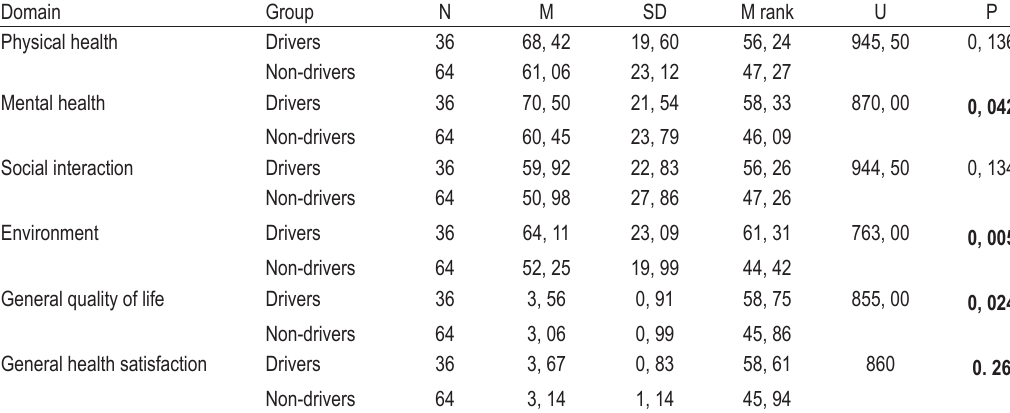
TABLE 3. Correlation between quality of life and respondents who are driver